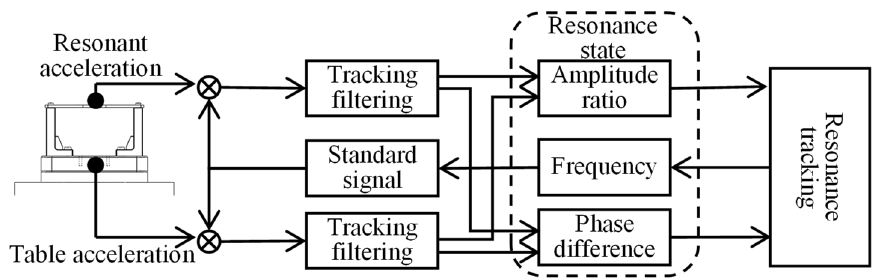
Figure 9. Phase-locked resonance tracking control.